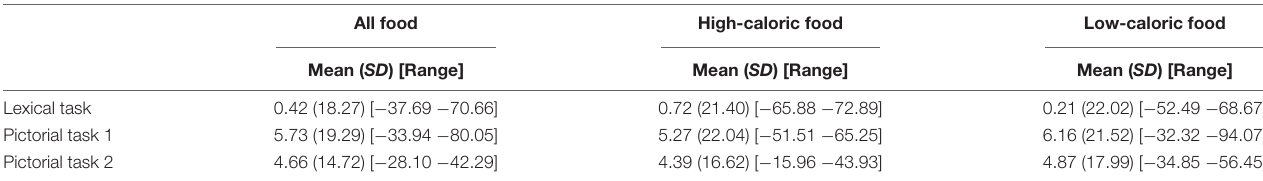
TABLE 1 | Attentional Bias scores for all tasks, by stimulus category.